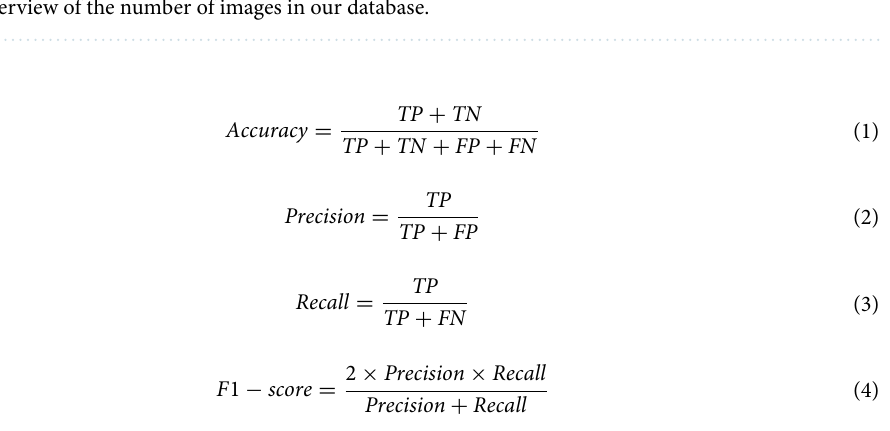
Table 6. Overview of the number of images in our